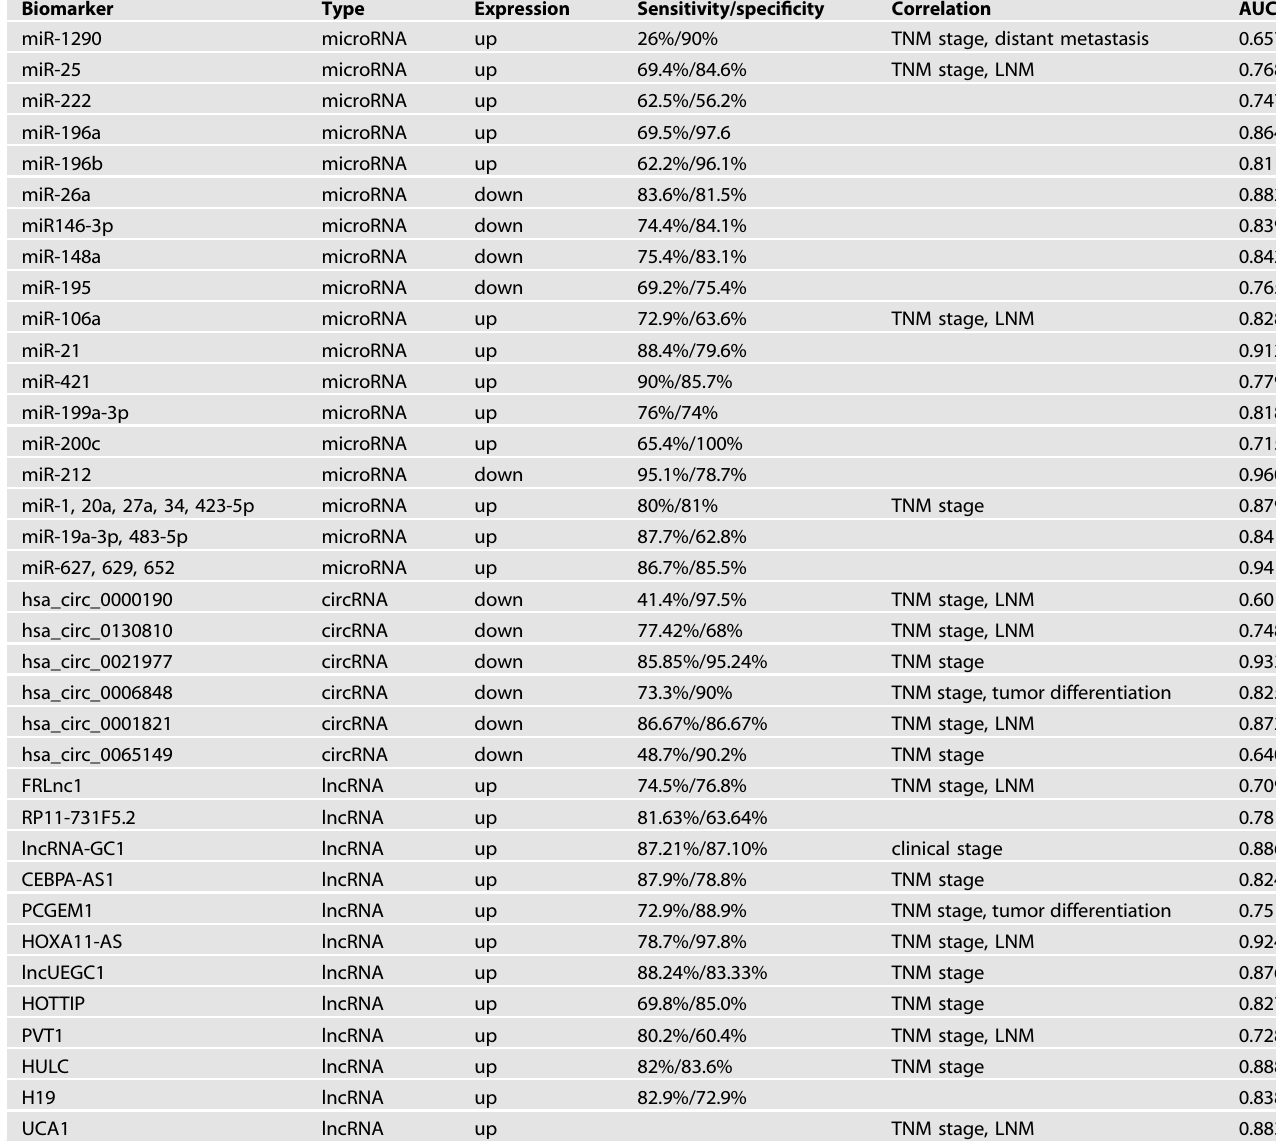
Table 2. Exosomal RNAs in diagnosis of